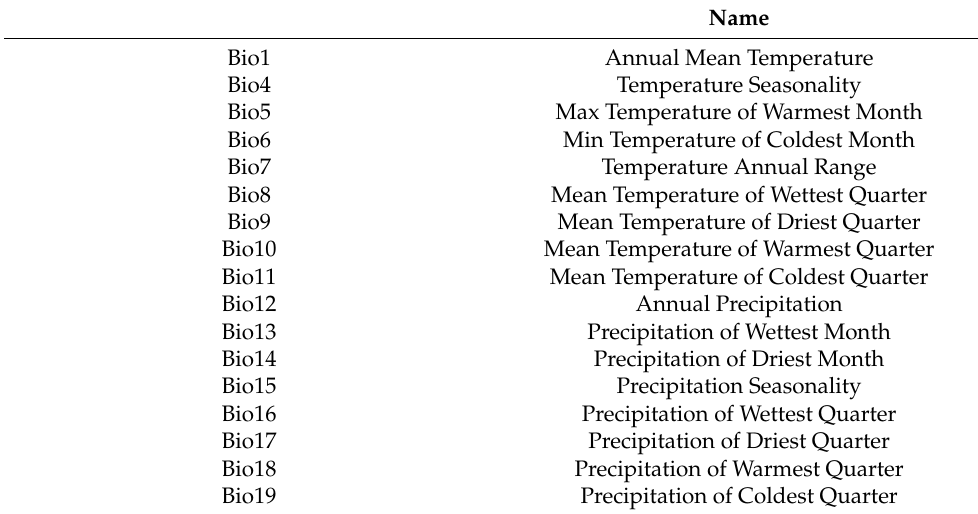
Table 2. CHELSA Bioclimate